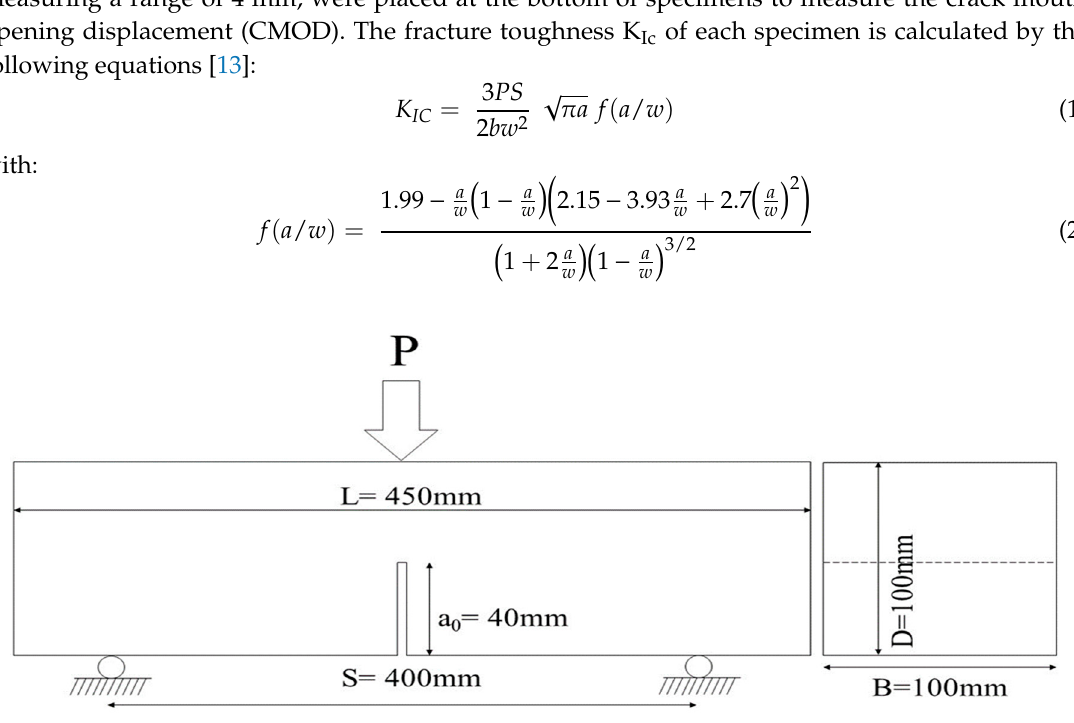
Figure 1. Experimental loading pattern.